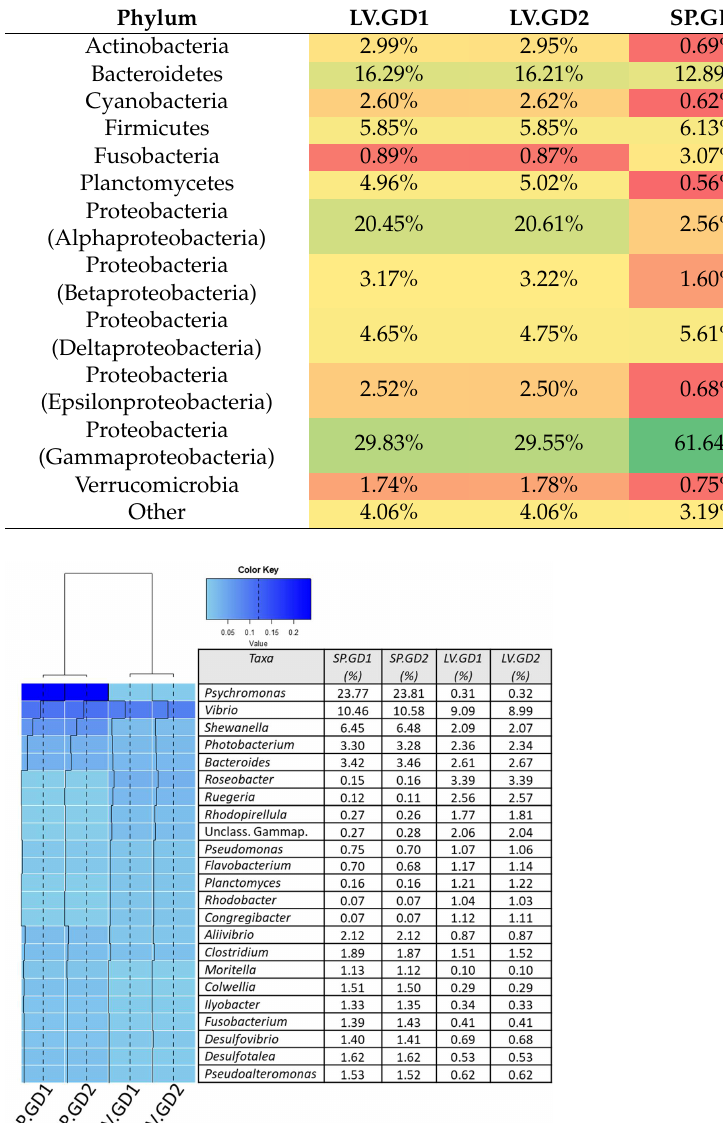
Table 2. Phylum (class for Proteobacteria) level heatmap table of the green and purple sea urchin gut digesta based on the taxonomic assignments determined through RefSeq. Phyla represented at <1% across all samples were listed as “Other”. The minimum and maximum relative abundance values were used to establish the gradient color scale, with 0.56% set at the minimum and 61.68% at the maximum. The gradient percentage values are indicated as follows: red = low; yellow = inter- mediate; green = high relative abundance. The table was generated using Microsoft Excel software (Microsoft, Seattle, WA, USA) using the conditional formatting option, and samples are indicated as follows: LV.GD = green sea urchin Lytechinus variegatus gut digesta; SP.GD = purple sea urchin Strongylocentrotus purpuratus gut digesta.